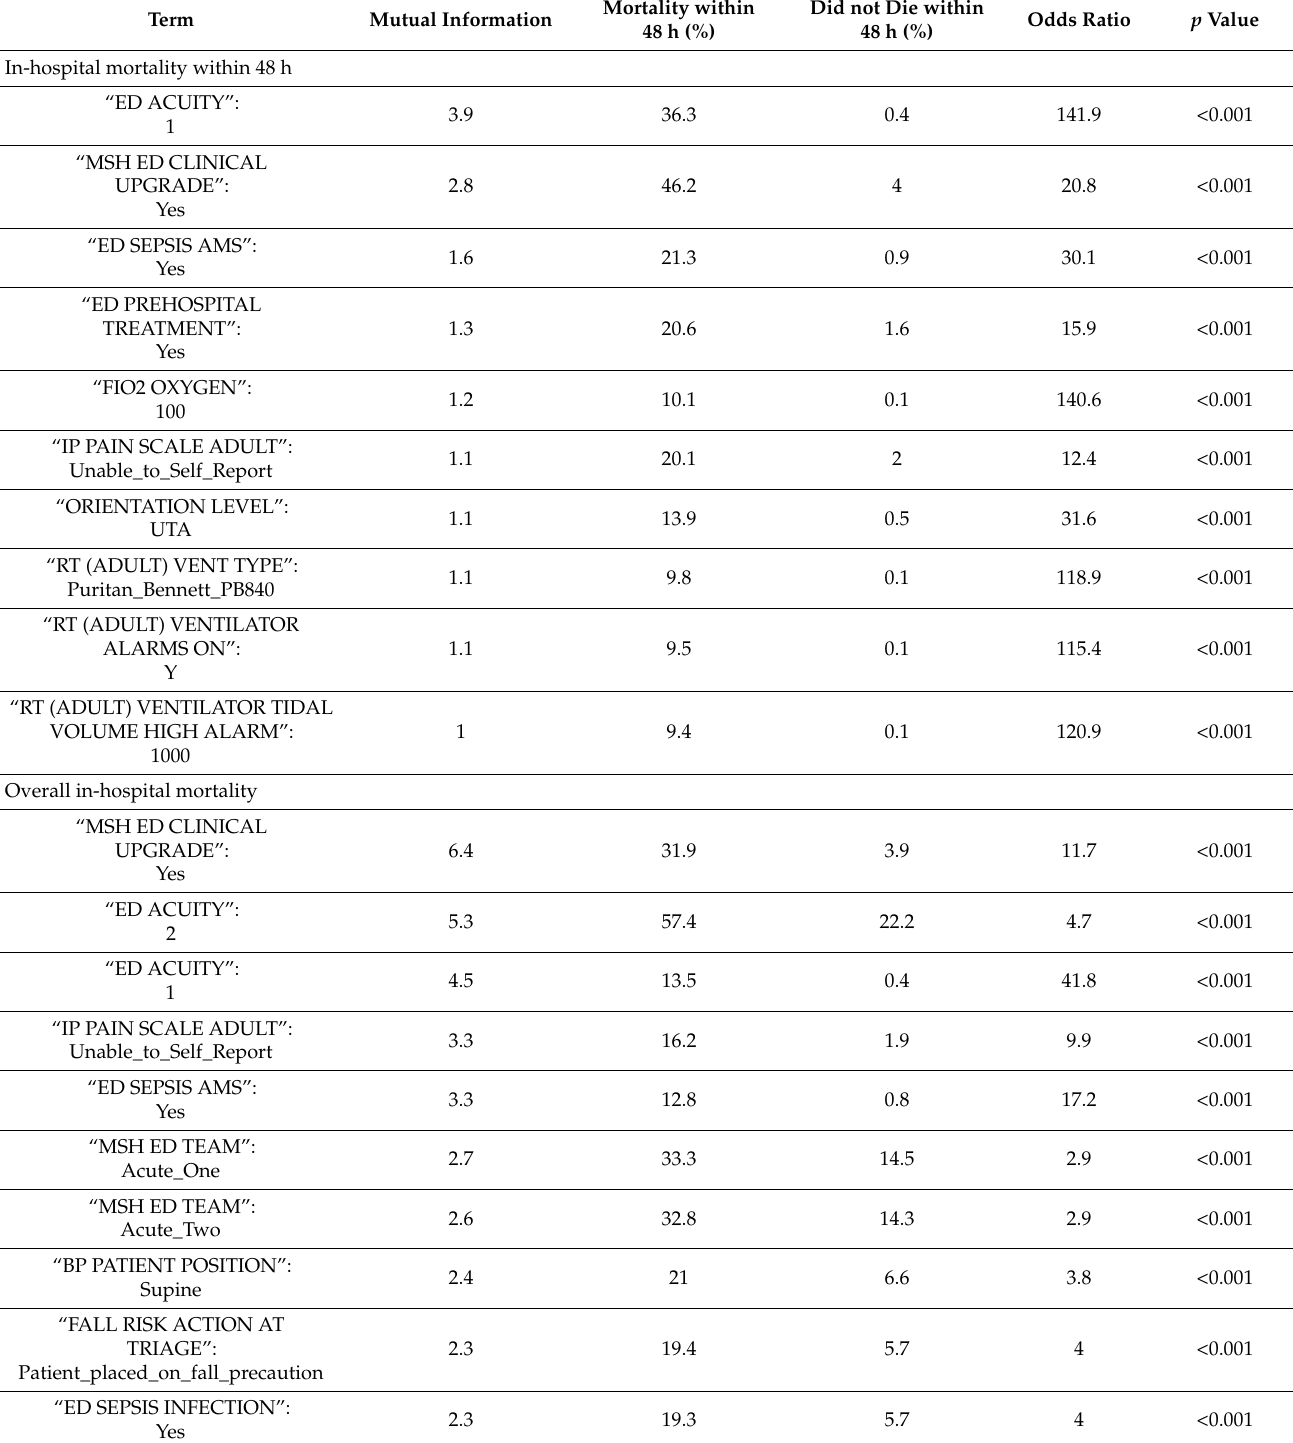
Table A1. Flowsheet terms associated with in-hospital mortality within 48 h and overall in-hospital mortality. Term Mutual Information